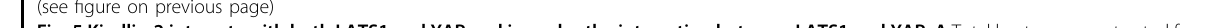
Fig. 5 Kindlin-2 interacts with both LATS1 and YAP and impedes the interaction between LATS1 and YAP. A Total lysates were extracted from TM4 cell lines (without treatments) for co-immunoprecipitation (Co-IP) experiments. Equal amount of proteins was immunoprecipitated separately with IgG or anti-Kindlin-2 antibody. Western blot displayed the expression of YAP, LATS1 and Kindlin-2 with speci fi c antibodies. B FLAG and FLAG- Kindlin-2 expression vector were transfected into TM4 cell lines separately. 48 h after transfection, total cell lysates were immunoprecipitated with anti-FLAG antibody and protein G-Sepharose. The expression of YAP, LATS1, and FLAG were detected with speci fi c antibodies by Western blot analysis. C Anti-YAP antibody was used for Co-IP experiment and the expression of Kindlin-2 was detected by speci fi c antibodies. D Anti-LATS1 antibody was used for Co-IP experiment and the expression of Kindlin-2 was detected by speci fi c antibody. E GFP-Kindlin-2 and FLAG-YAP expression vector were transfected into HEK293T cell lines separately. 48 h after transfection, total cell lysates were immunoprecipitated with anti-FLAG antibody and protein G-Sepharose. The expression of YAP and FLAG were detected with speci fi c antibodies by Western blot analysis. F 15P-1 cells were stained with an anti-YAP mouse (red) and an anti-Kindlin-2 rabbit (green). Nuclei were stained with DAPI (blue), followed by visualization with confocal microscopy. Scale bars, 10 μ m. Magni fi cation were shown. G 15P-1 cells were stained with an anti-LATS1 mouse (red) and an anti-Kindlin-2 rabbit (green). Nuclei were stained with DAPI (blue), followed by visualization with confocal microscopy. Scale bars, 10 μ m. Magni fi cation were shown. H – J Indicated truncates of Kindlin-2, YAP and LATS1 were constructed according to the functional domains respectively. YAP contains two WW domains in the middle and a transactivation domain at the C terminus. LATS1 contains a kinase region in the middle part. K HEK293 cells were transfected with the indicated truncates of GFP-Kindlin-2. Cell lysates were incubated with GST or GST-YAP in vitro for GST pull-down assays followed by immunoblotting using an anti-GFP antibody. L Puri fi ed His-Kindlin-2 protein was incubated with puri fi ed GST or GST-YAP fragments at 4 °C overnight. Beads were washed and the remaining proteins were resolved by SDS-PAGE and further analyzed by Western blot analysis using anti-Kindlin-2 antibody (upper panel). The GST and GST-YAP were stained by Coomassie blue (lower panel). M HEK293 cells were transfected with the indicated truncates of GFP-Kindlin-2. Cell lysates were incubated with GST or GST-LATS1-Kinase region in vitro for GST pull-down assays followed by immunoblotting using an anti-GFP antibody. N HEK293 cells were co-transfected with GFP-Kindin-2 and the indicated truncates of FLAG-LATS1. Cell lysates were incubated with anti-FLAG antibody and protein G-Sepharose. The expression of GFP and FLAG were detected with speci fi c antibodies by Western blot analysis. O , P Kindlin-2 isolates the interaction between LATS1 and YAP. O GFP or GFP-Kindlin-2 were co-transfected with FLAG-LATS1 into HEK293T cell lines. P Control siRNA or Kindlin-2 siRNA were co-transfected with FLAG-LATS1 into HEK293T cell lines. Co-immunoprecipitation was performed after 48 h transfection with FLAG-M2 beads. Western blot showed the expression of immunoprecipitation lysis YAP and FLAG and unprocessed lysis YAP, FLAG and Kindlin-2. Q Within the red rectangle is the brief working model of Kindlin-2 inactivating Hippo signaling pathway by interacting with LATS1 and YAP to inhibit the phosphorylation of YAP and to promote YAP nuclear localization. Outside the red rectangle is widely known Hippo signaling activation